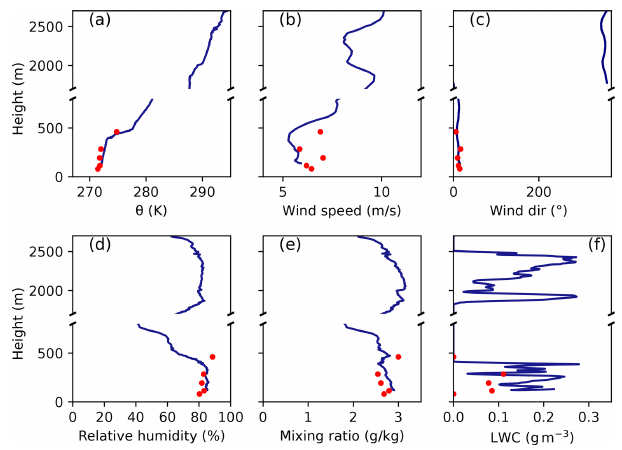
Figure 9. Results for 14 June 2017 obtained from a descent of Po- lar 6 in between the locations of the northernmost horizontal legs and the middle ones shown in Fig. 8.